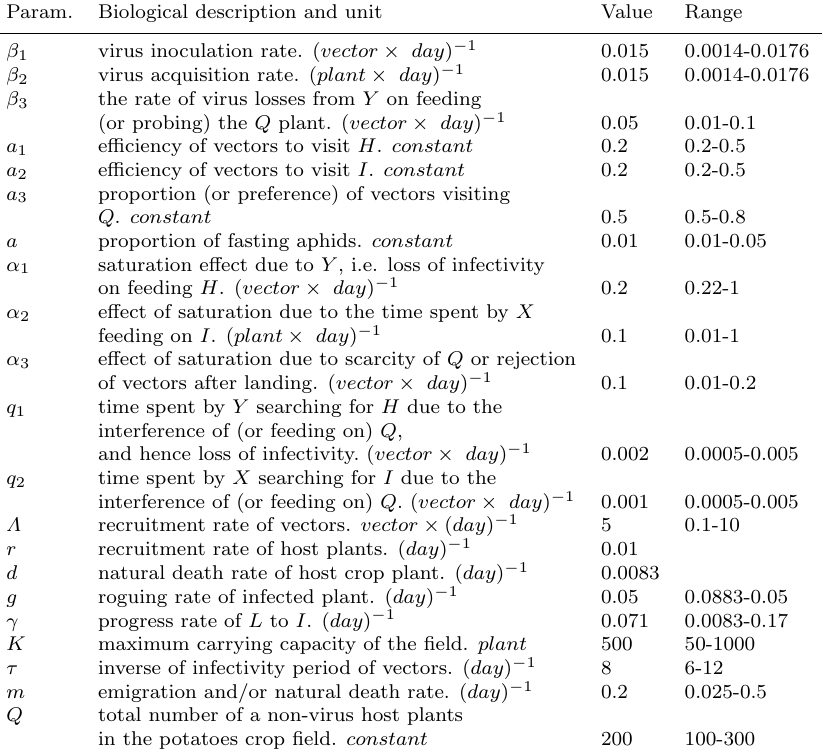
Table 1. Biological/ecological descriptions of the model parameters and their illustrative values to be used for numerical simulations. Param. Biological description and unit Value Range β